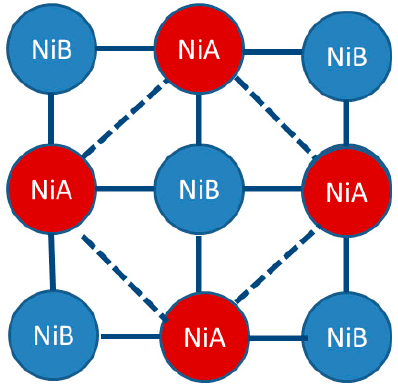
Figure 2. Tetracyano-nickelate square planar complex showing two different types of Nis (different coordination environment).